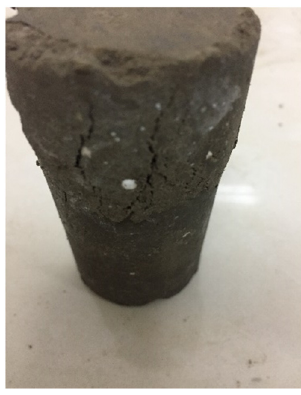
Figure 5: The rebound test site. Figure 3: The broken sample in uncon fi ned compressive test.